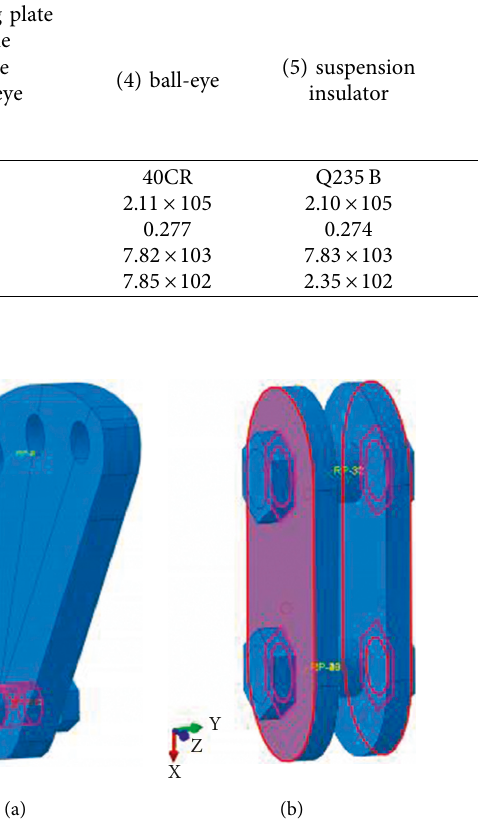
Figure 19: Constraint relationship: (a) “Coupling” constraint, (b) “Tie” constraint.